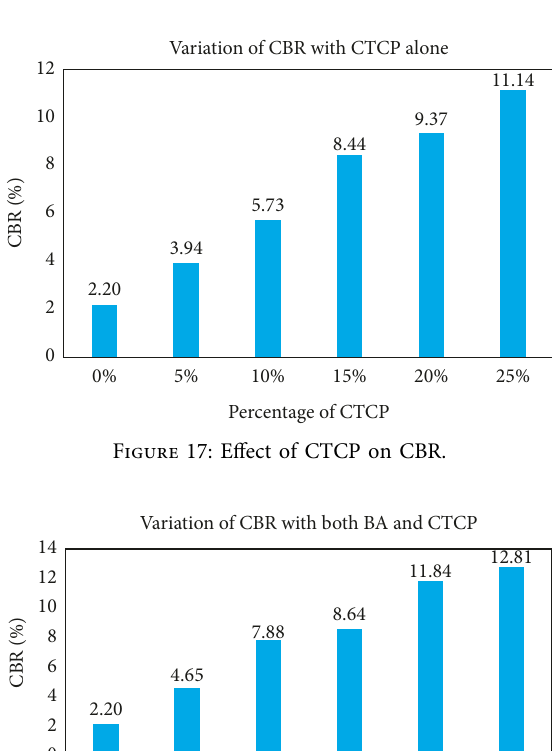
Figure 16: Effect of BA on CBR.